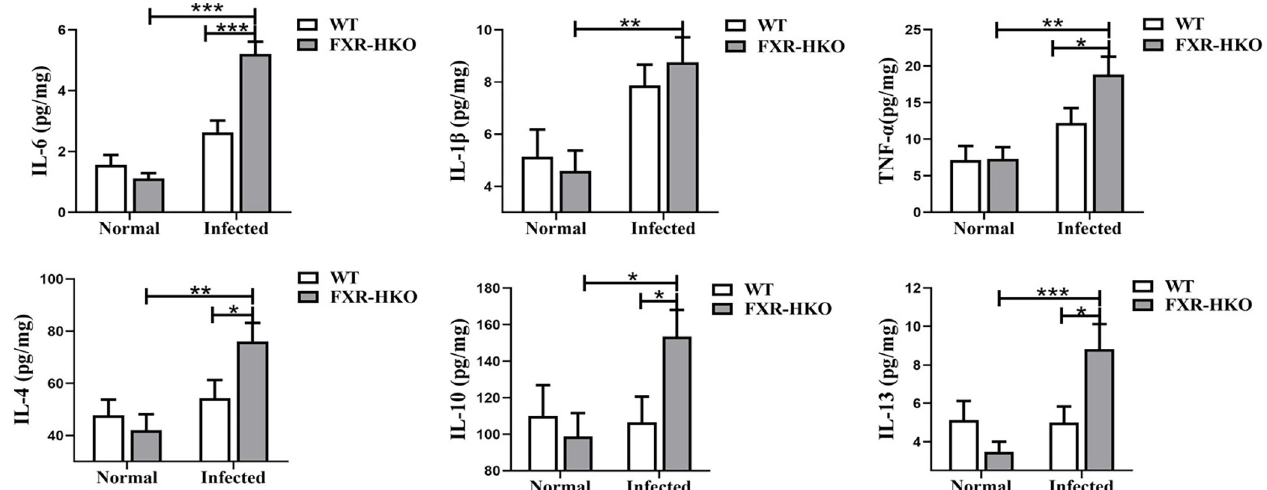
Fig 4. FXR deficiency promotes inflammatory cytokines production caused by S . japonicum infection. The levels of interleukin-6 (IL-6) (A), Interleukin-1 β (IL-1 β ) (B), Tumor necrosis factor- α (TNF- α ) (C), Interleukin-4 (IL-4) (D), Interleukin-10 (IL-10) (E), and Interleukin-13 (IL-13) (F) in liver from each group were detected by ELISA. Data are presented as mean ± SEM. � P < 0.05, �� P < 0.01, ��� P < 0.001.